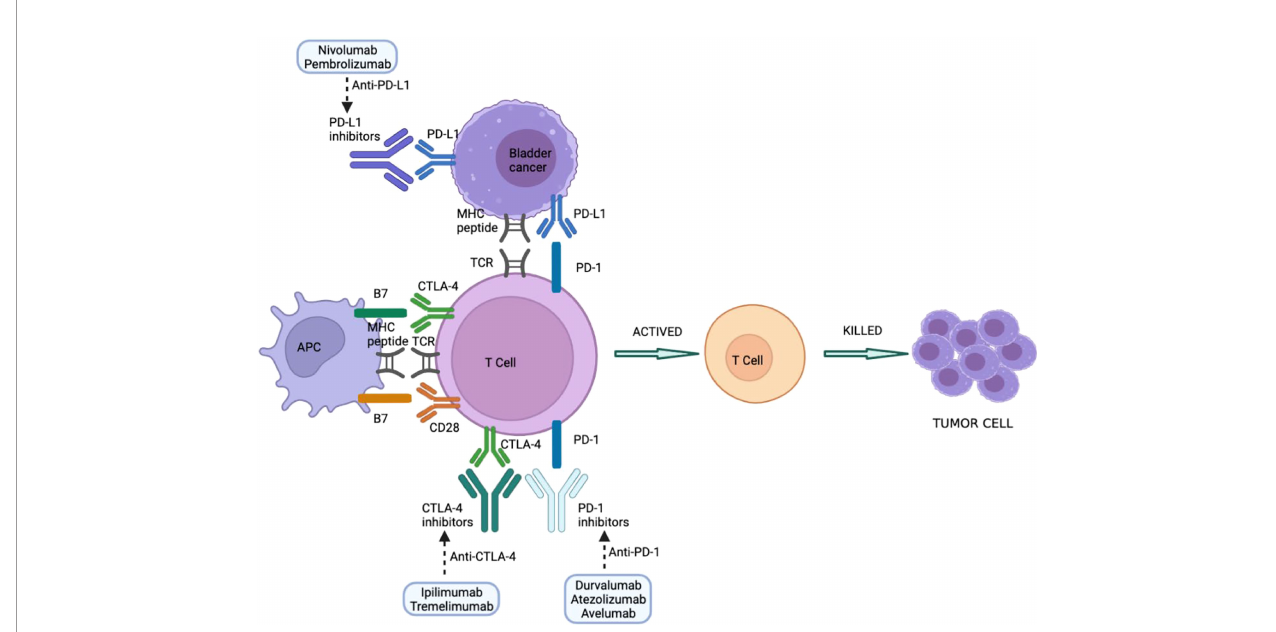
FIGURE 1 | Immune checkpoint inhibitors in BC treatment. PD-1/PD-L1 and CTLA-4 blockers interfere with suppression of checkpoint molecules of the immune system, leading to T-cell activation and tumor cell killing. CTLA-4, cytotoxic T-lymphocyte antigen 4; MHC, major histocompatibility complex; PD-1, programmed cell death-1; PD-L1, programmed cell death-1 ligand; TCR, T cell receptor; APC: Antigen-presenting